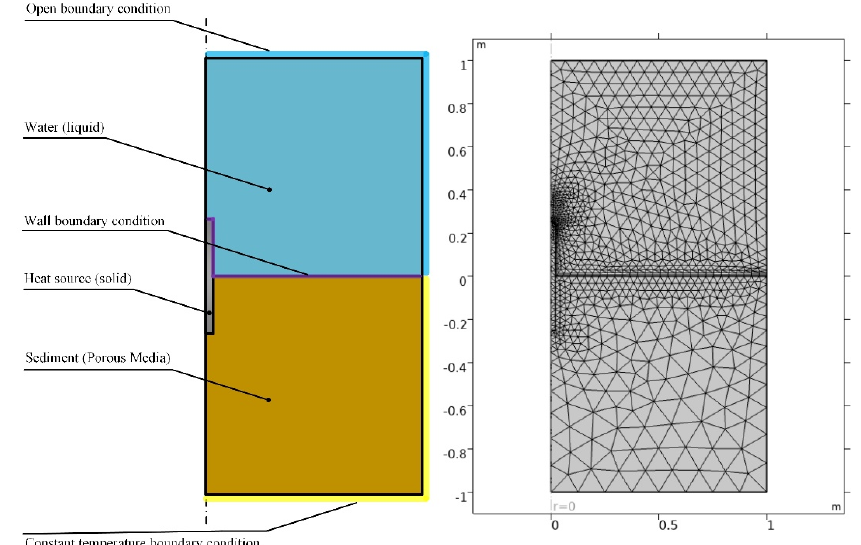
Figure 5. The schematic of the boundary conditions and meshing of the simulation model.